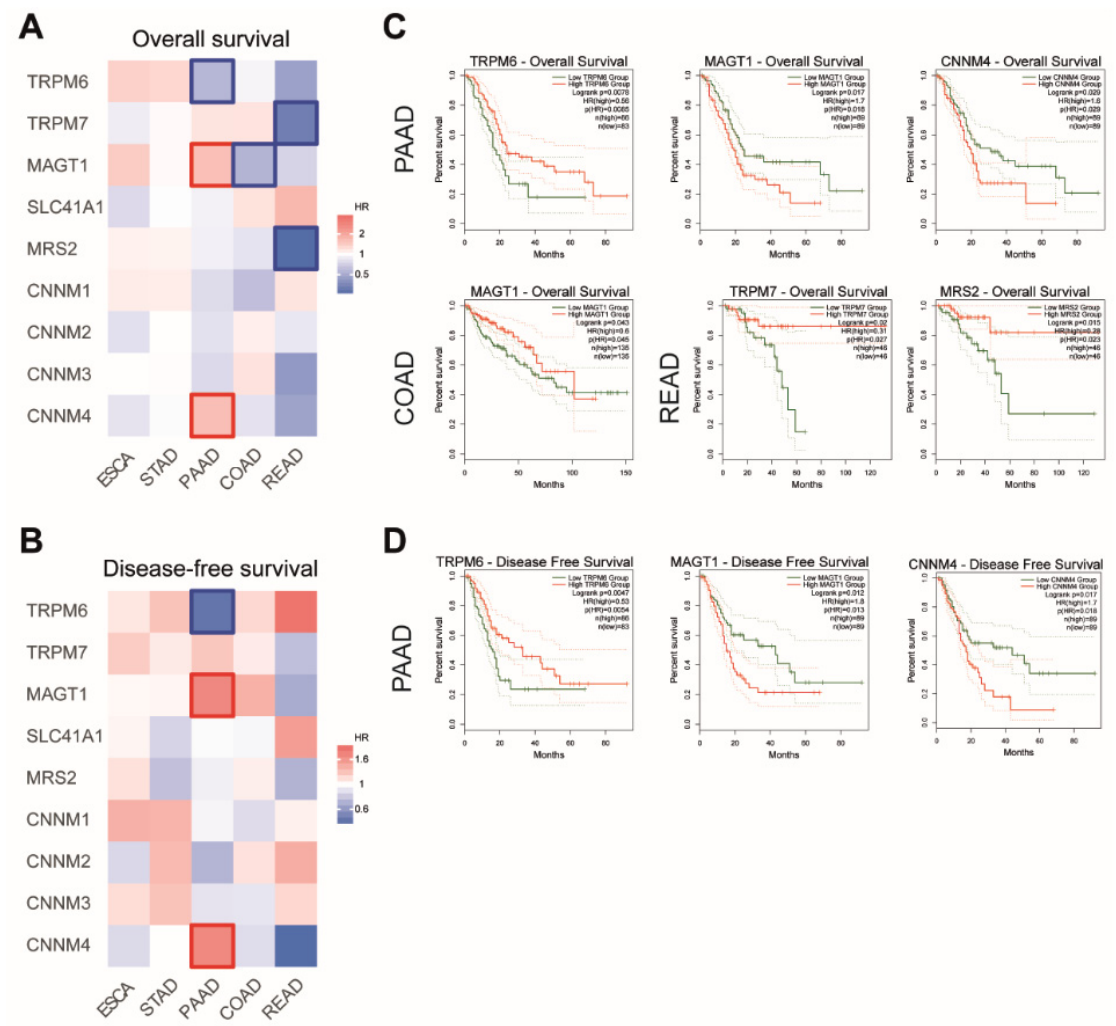
Figure 4. Analysis of patient survival in digestive cancers. Survival heatmaps were generated using GEPIA2 with TCGA data for overall survival ( A ) and disease-free survival ( B ) for Esophageal Cancer (ESCA), Stomach Adenocarcinoma (STAD), Pancreatic Adenocarcinoma (PAAD), Colon Adenocarcinoma (COAD) and Rectum Adenocarcinoma (READ) datasets. Survival is expressed as hazard ratio (HR). Framed squares represent significative statistical values ( p < 0.05). Kaplan–Meier curves for overall survival ( C ) and disease-free survival ( D ) were analyzed using GEPIA2. TRPM6, Transient Receptor Potential Cation Channel Subfamily M, Member 6. TRPM7, Transient Receptor Potential Cation Channel Subfamily M, Member 7; MAGT1, Magnesium Transporter 1; SLC41A1, Solute Carrier Family 41, Member 1; MRS2, Mitochondrial RNA Splicing Protein 2; CNNM4, Cyclin and CBS Domain Divalent Metal Cation Transport Mediator 4. Only statistically significant curves (* p < 0.05 ) are presented.